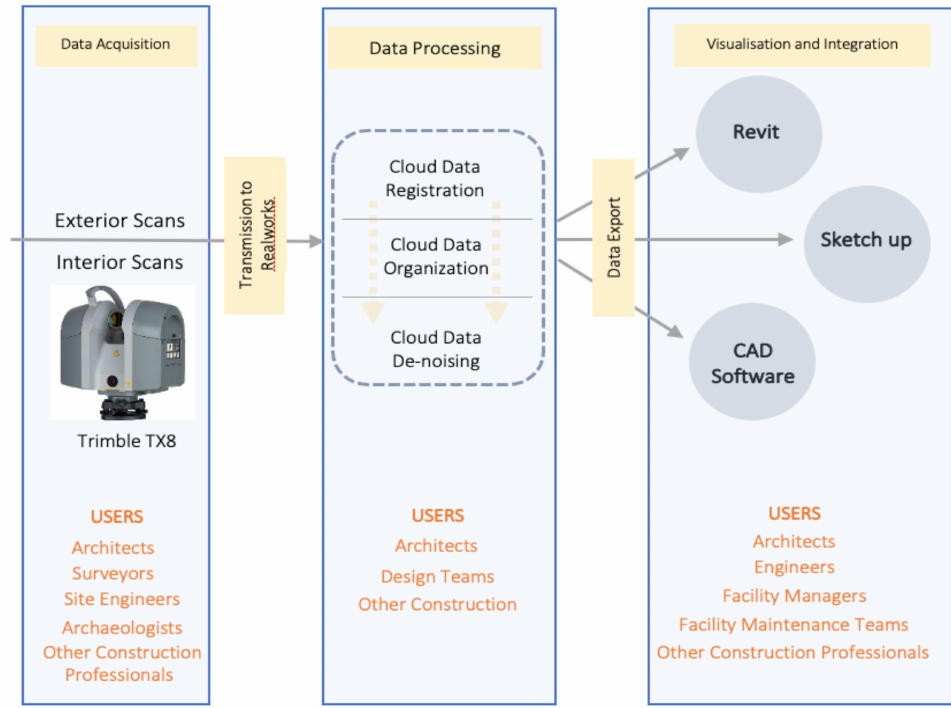
Figure 4. Cloud data examination